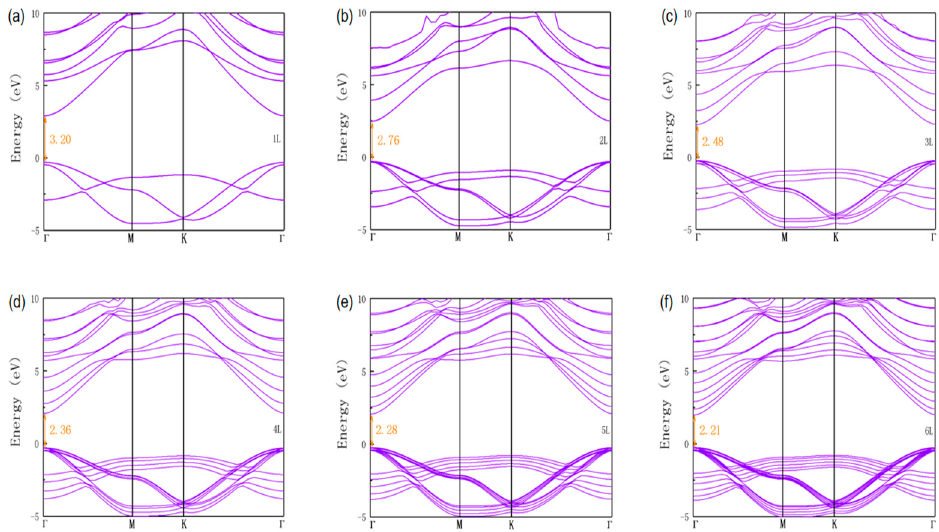
Figure 2. Band structures of ( a ) 1L, ( b ) 2L, ( c ) 3L, ( d ) 4L, ( e ) 5L, and ( f ) 6L ZnO were calculated using the HSE06 functional. Fermi level was set to 0 eV .